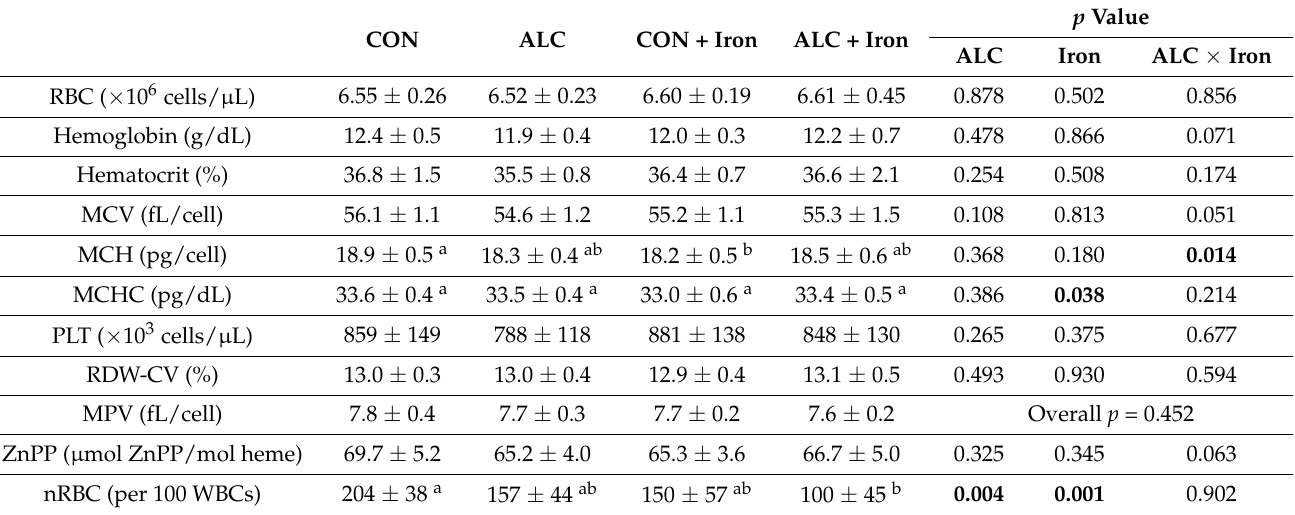
Table 4. Alcohol exposure and iron supplementation minimally affected maternal hematology. CON ALC CON + Iron ALC + Iron